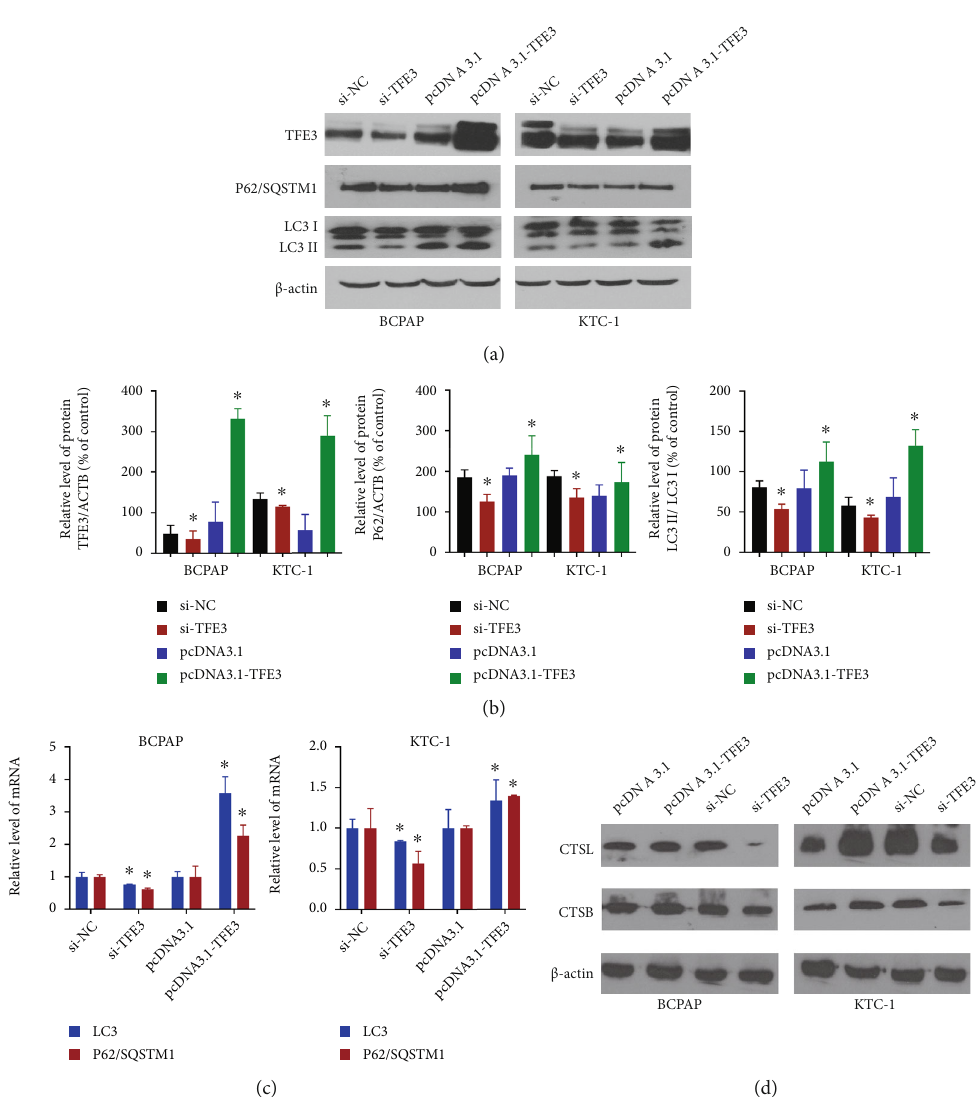
Figure 5: TFE3 induces autophagy-lysosome in PTC cells. (a, b) After transfection with pcDNA3.1-TFE3 or si-TFE3, BCPAP and KTC-1 cells showed signi fi cant changes in TFE3 protein levels. Overexpression of TFE3 increased the expression of P62/SQSTM1, and the opposite results were observed in BCPAP and KTC-1 cells transfected with si-TFE3. The ratio of LC3II/LC3Iin BCPAP and KTC-1 cells increased signi fi cantly after pcDNA3.1-TFE3 transfection, and the opposite results appeared after si-TFE3 transfection. (c) After knocking down TFE3, the expression of LC3 and P62/SQSTM1 in PTC cells was decreased, and overexpression of TFE3 increased the expression of LC3 and P62/SQSTM1 in PTC cells ( ∗ P < 0 : 05 ). (d) After knocking down TFE3, the expression of CTSB and CTSL in PTC cells was decreased, while TFE3 is overexpression, the expression of CTSB and CTSL in PTC cells increased ( ∗ P < 0 : 05